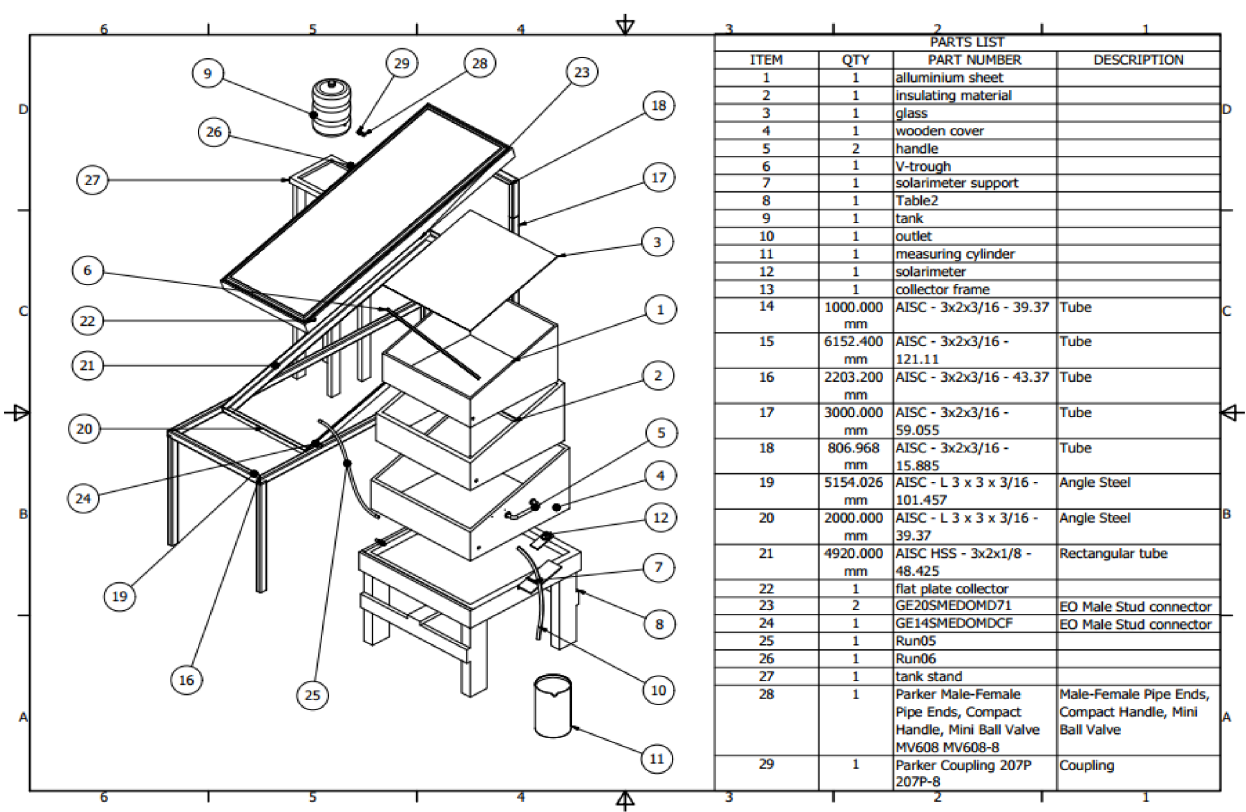
Figure 1. Isometric diagram and exploded view of the experimental set-up.